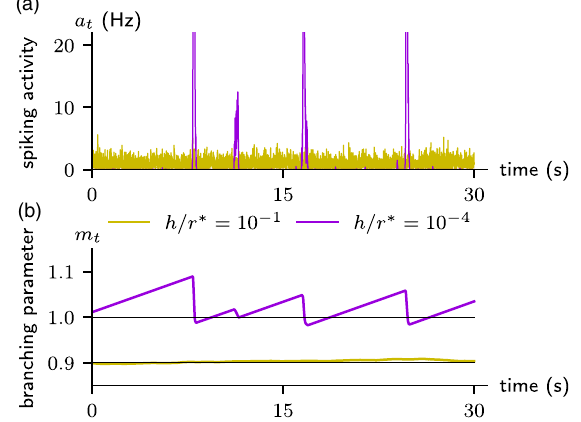
FIG. 7. Temporal fluctuations in an annealed-average network with homeostatic plasticity subject to different external input rates. (a) Spiking activity a t shows small fluctuations for large input rates (yellow) and bursts for small input rates (purple); cf. Fig. 3. (b) Branching parameter fluctuates around predicted value (black horizontal lines) and develops a distinct sawtooth pattern for small input